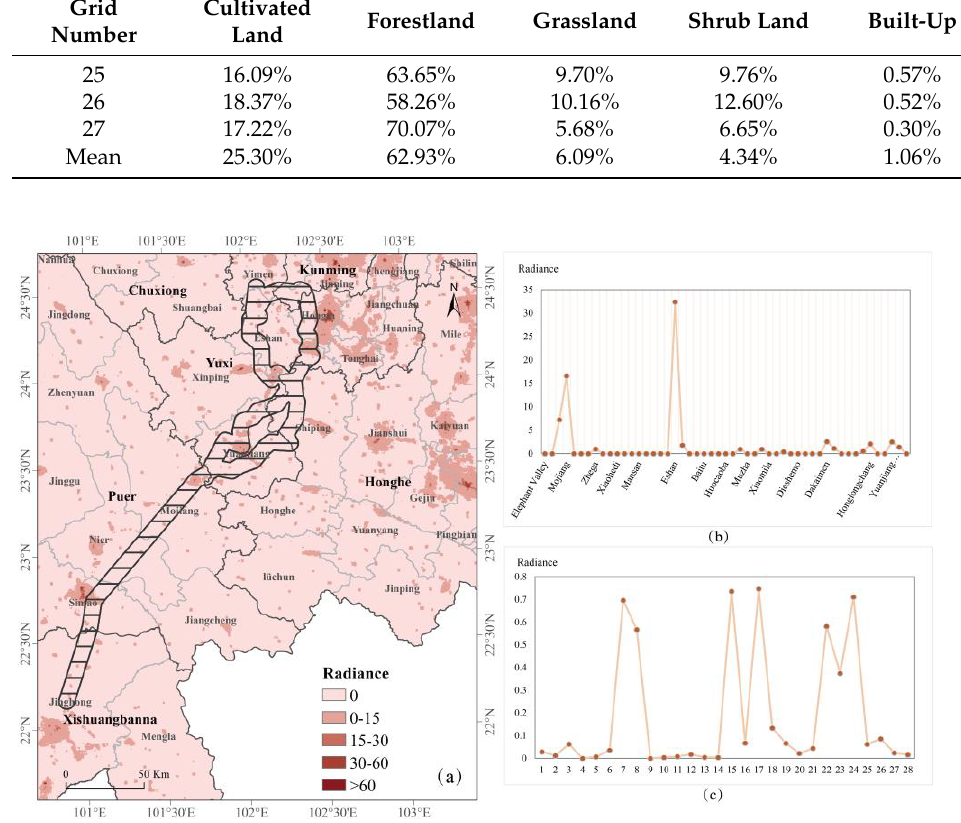
Figure 6. Night light index of the movement route of Asian elephants. The figure was composed of three parts: ( a ) the spatial pattern of the night light index, ( b ) the night light index change curve of recorded locations, and ( c ) the night light index change curve of the buffer grid from south to north. Table 1. Proportions of land use types on the Asian elephant movement route.